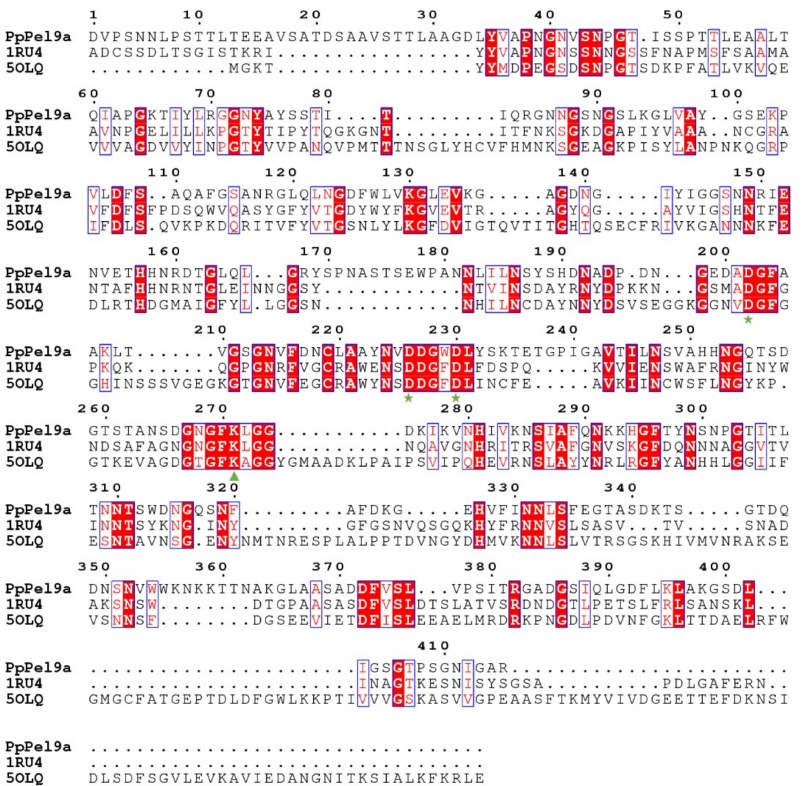
Figure 1. Alignment of amino acid sequence of PpPel9a with the PL9 family pectate lyases: Pel9A from E. chrysanthemi (1RU4) and rhamnogalacturonan lyase from B. thetaiotaomicron VPI-5482 (PDB